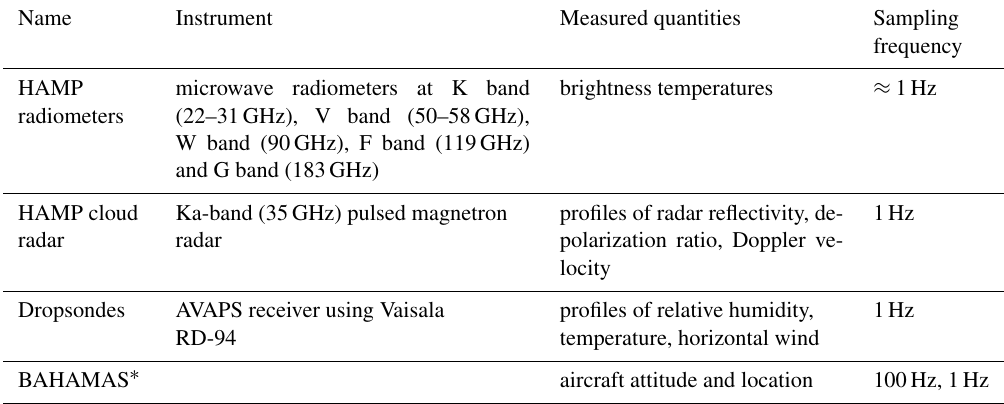
Table 5. Instruments used all four campaigns that provided measurements for this data